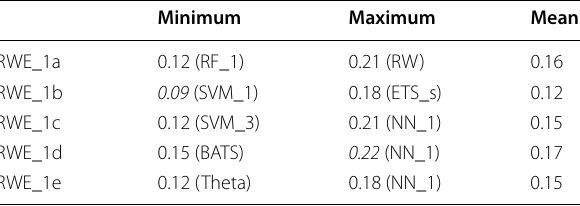
The minimum of the minimum values and the maximum of the maximum values are in italic